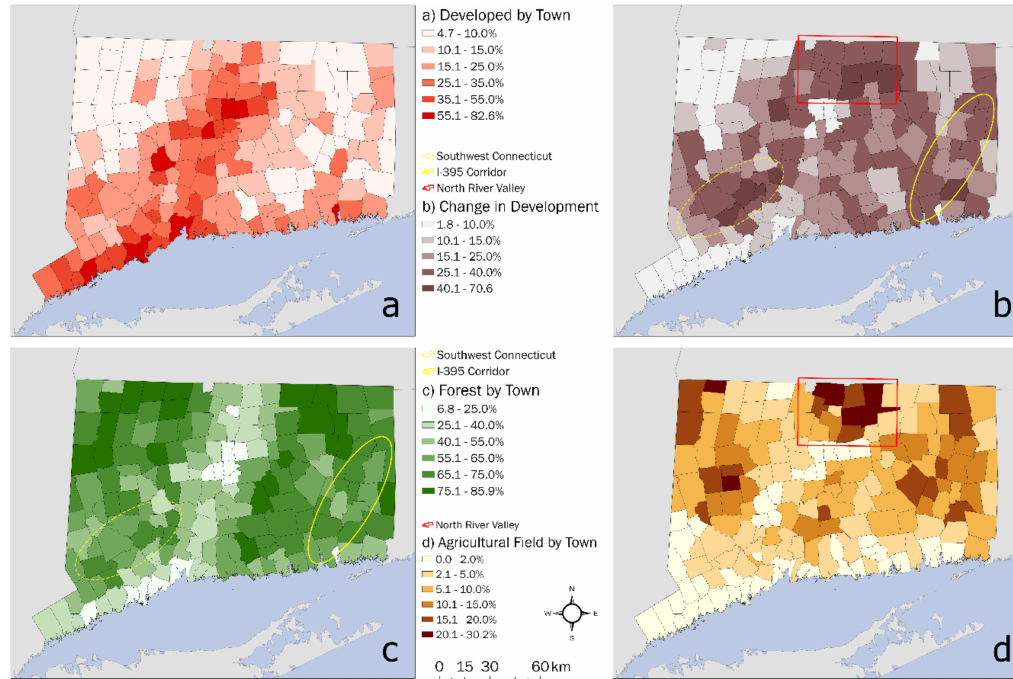
Figure 14. For all maps ( a – d ), darker colors represent higher percentages. ( a ) Percentage developed, by town, 2015, showing historical development patterns along transportation corridors Interstate 95 (coastal) and Interstate 91 (south to north). ( b ) Relative change in development 1985–2015, by town, showing more recent development patterns. ( c ) Percentage forest, by town, 2015. ( d ) Percentage agricultural field by town, 2015. The yellow circles highlight areas where new development is occurring in forested areas and the red square highlights the largely agricultural area in the northern river valley which is also a hot spot of new